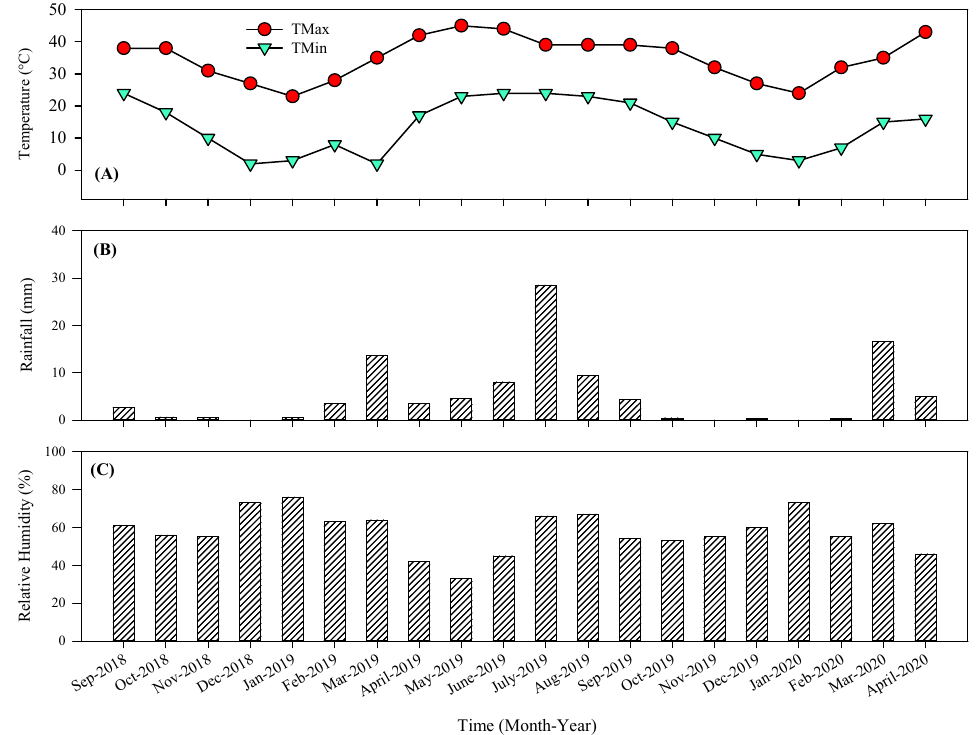
Figure 1. Tmax, maximum temperature, and Tmin, minimum temperature ( A ), average rainfall ( B ), and average relative humidity ( C ) occurring at the experimental location (Source: Pakistan Meteorological Department).